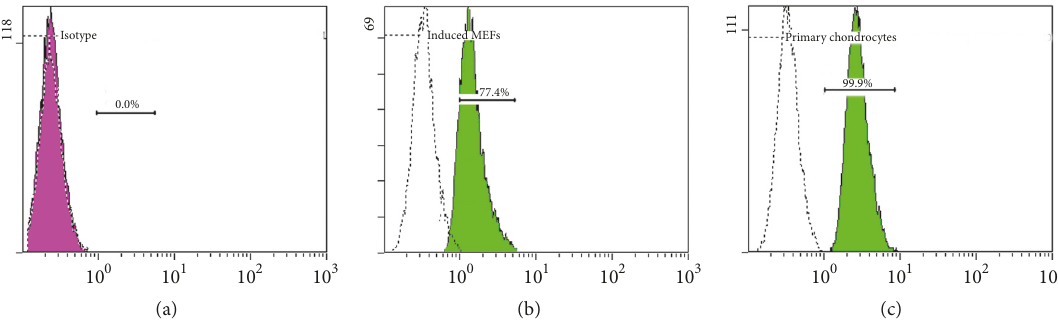
Figure 9: Reprogramming efficiency: (a) Isotype group; (b) induced MEFs group; (c) primary chondrocytes